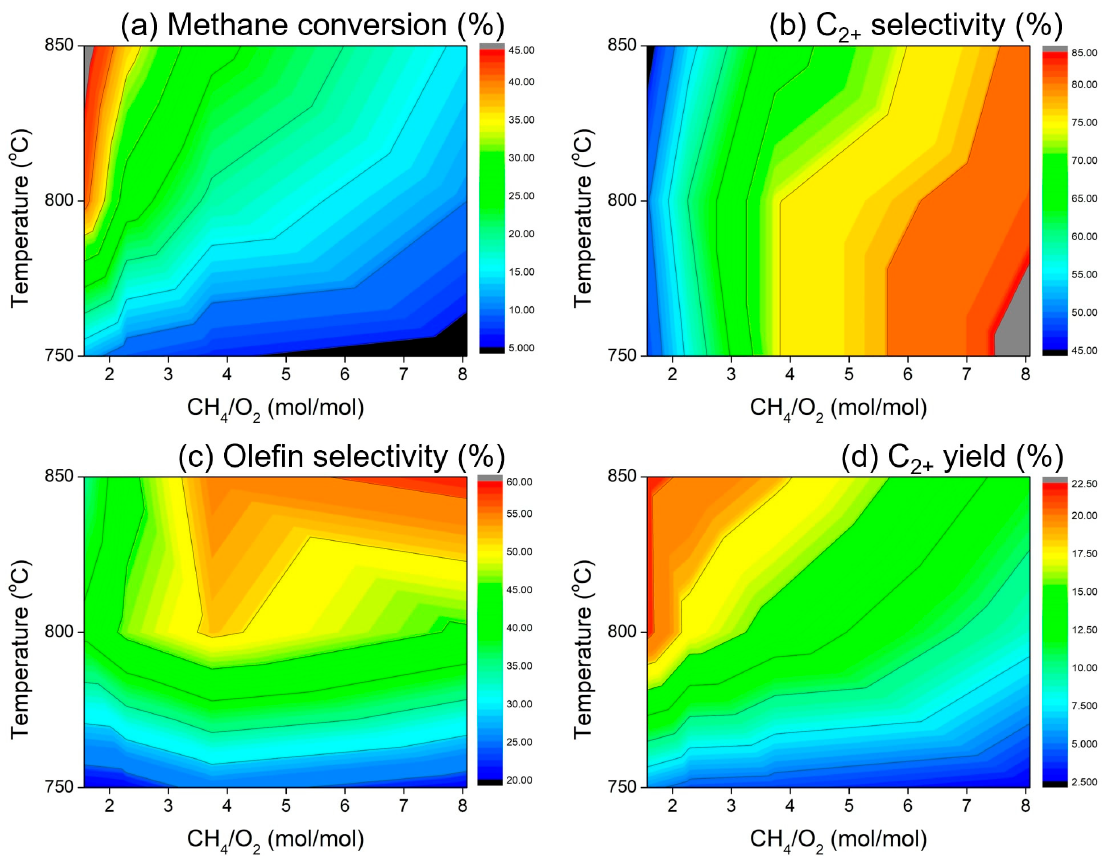
Figure 8. Optimization of the CH 4 /O 2 ratio and temperature for the oxidative coupling of methane activity. ( a ) CH 4 conversion, ( b ) C 2+ selectivity, ( c ) Olefin selectivity, ( d ) C 2+ yield.